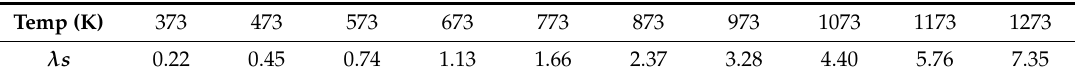
Table 6. Calculation conditions for pilot-scale CFD simulations (Physical properties of materials). Item Density (g/m 3 ) Specific Heat (J/kgK) Thermal Conductivity (W/Mk) Slag 2200 1010 λ s 100 1256 0.2 8030 502 Table 7. Calculation conditions for pilot-scale CFD simulations (Heat conductivity of